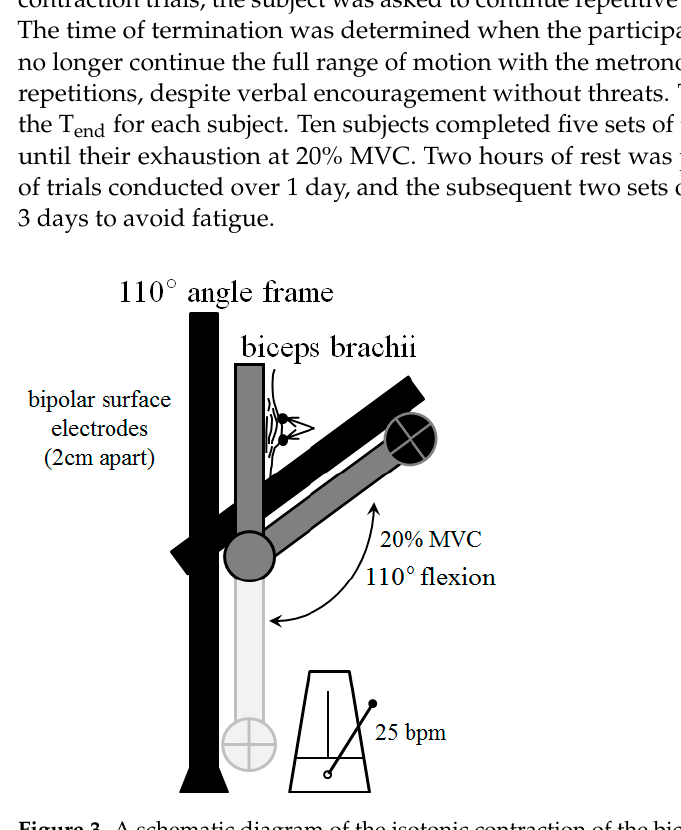
Figure 4. The initial screen.